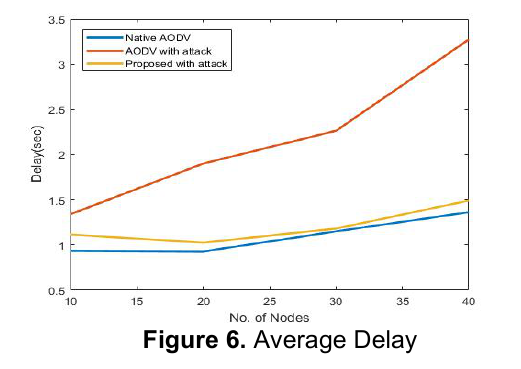
Figure 6. Average